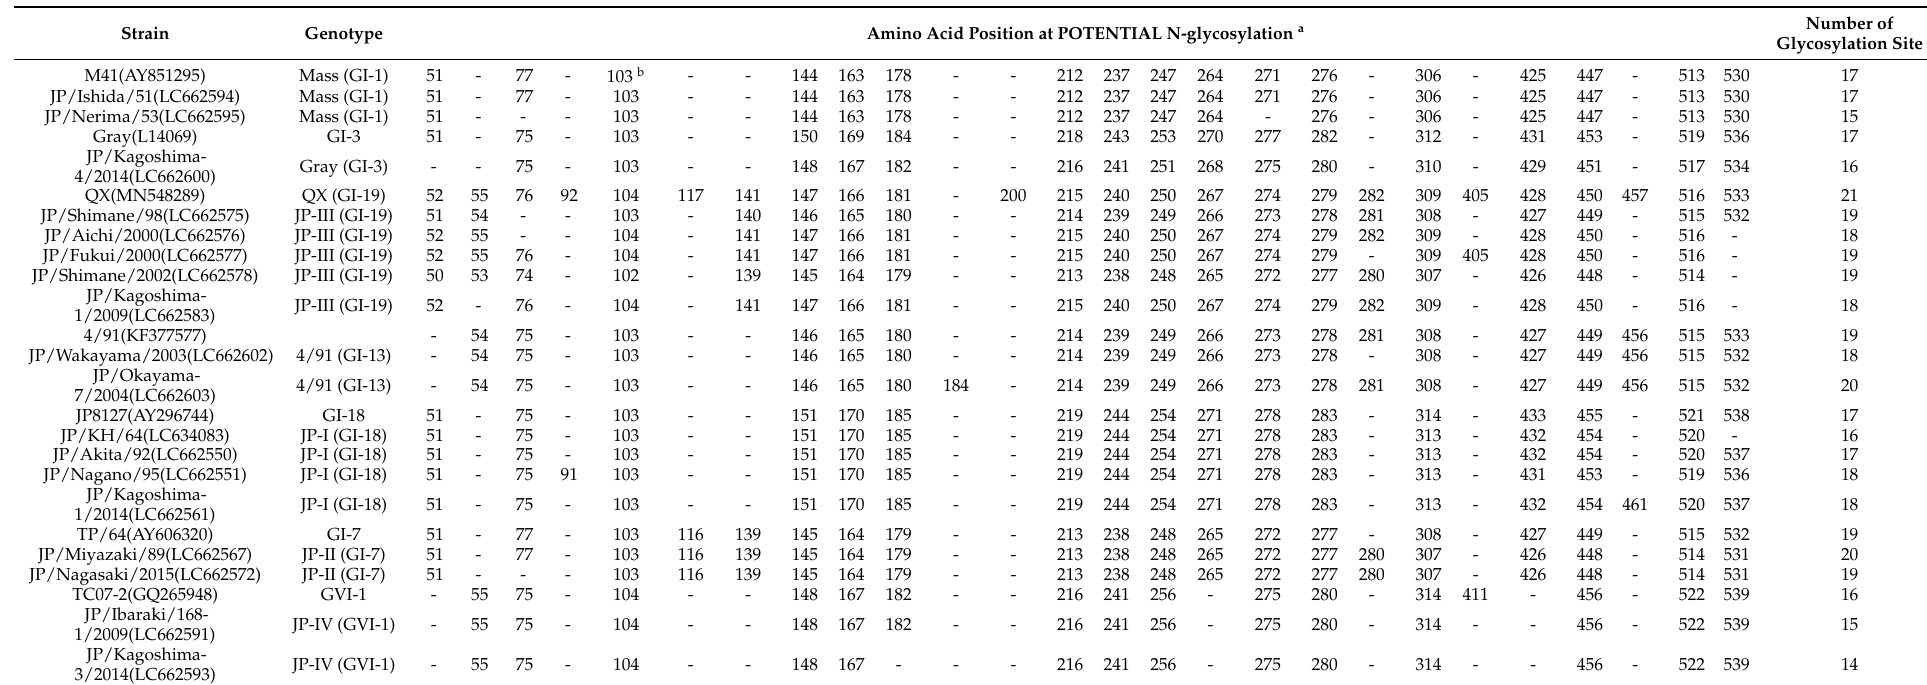
Table 5. Potential N-glycosylation sites of Japanese IBV